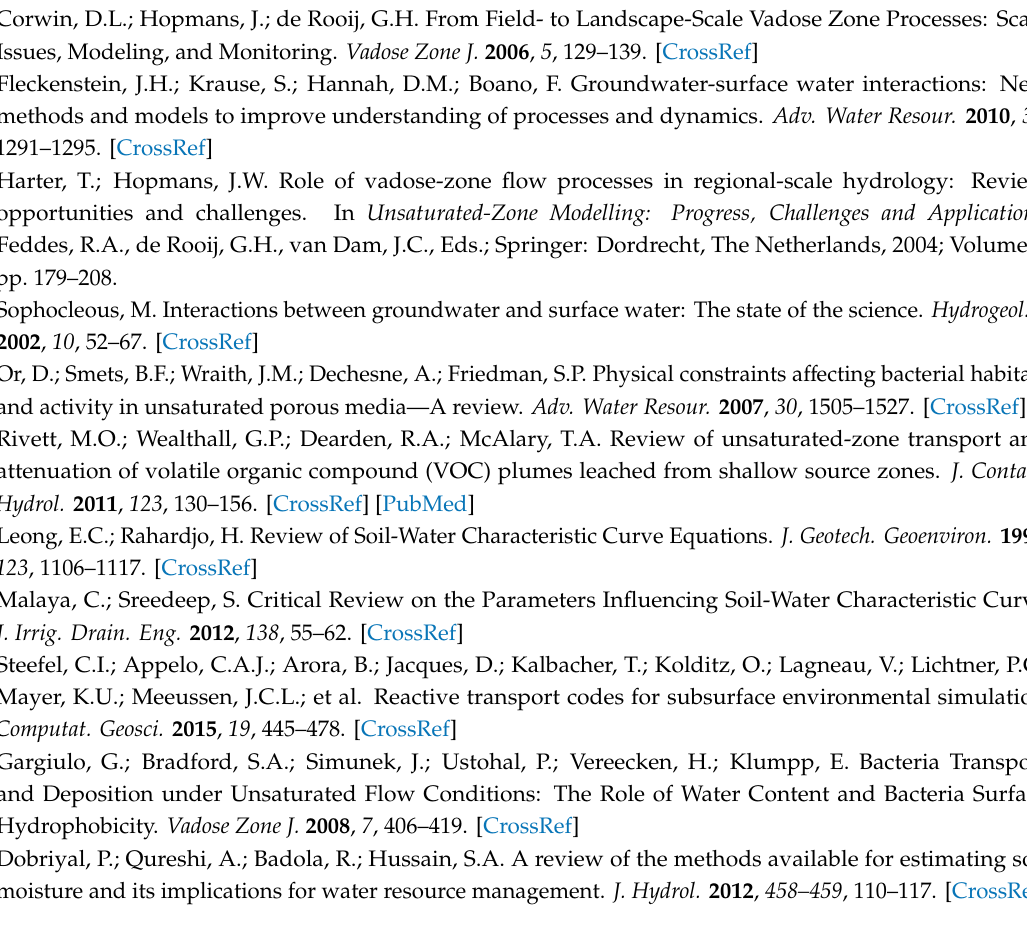
Figure S1: Plans of the tank, Figure S2: Pictures of the tank, Video S1: 1st experiment, Video S2: 2nd